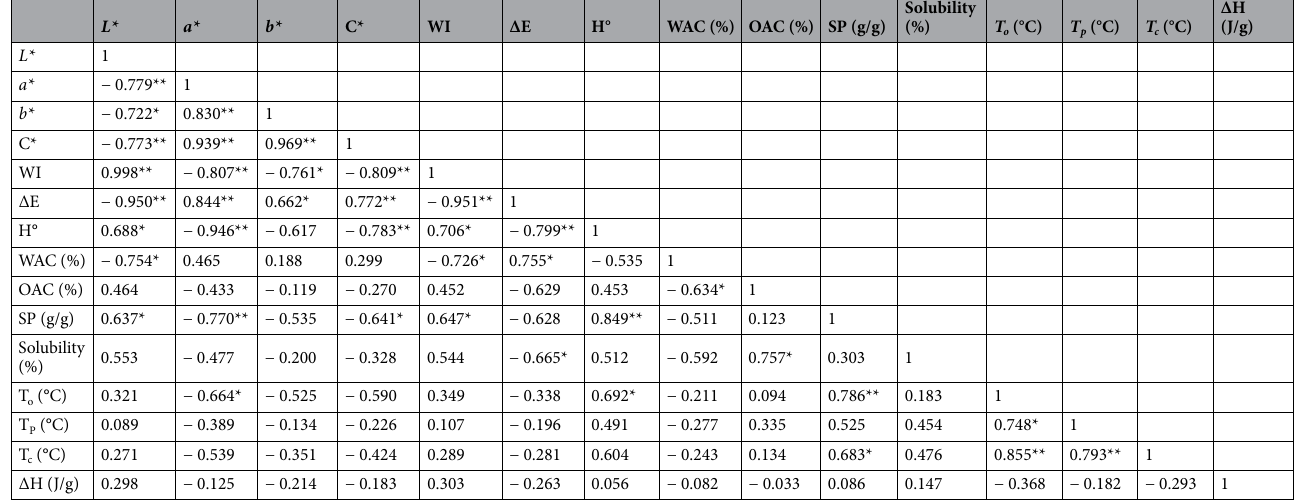
Table 12. Correlation matrix of colour, functional and thermal properties of HMT 35 Bambara groundnut starch. WAC: water absorption capacity; OAC: oil absorption capacity; SP: swelling power; ∆H: gelatinization enthalpy; ∆E: total colour difference, WI: whiteness index; L* : lightness/whiteness; a* : yellowness/redness; b* : blueness/greenness; C*: chroma; H°: hue; T o : onset temperature; T p : peak temperature; T c : conclusion temperature; ∆H: gelatinization enthalpy. **Correlation is significant at the 0.01 level; *Correlation is significant at 0.05 level.